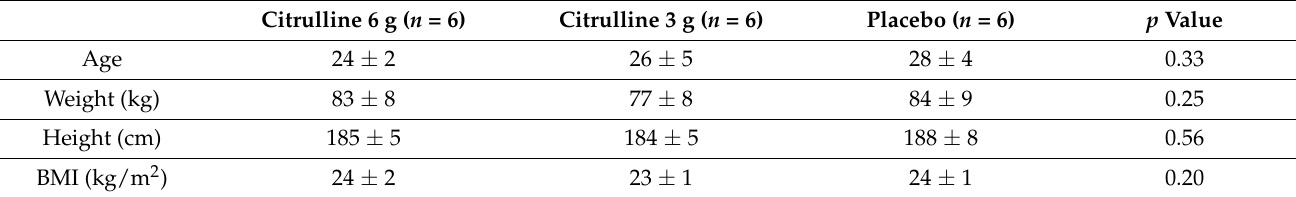
Table 1. Participant age and